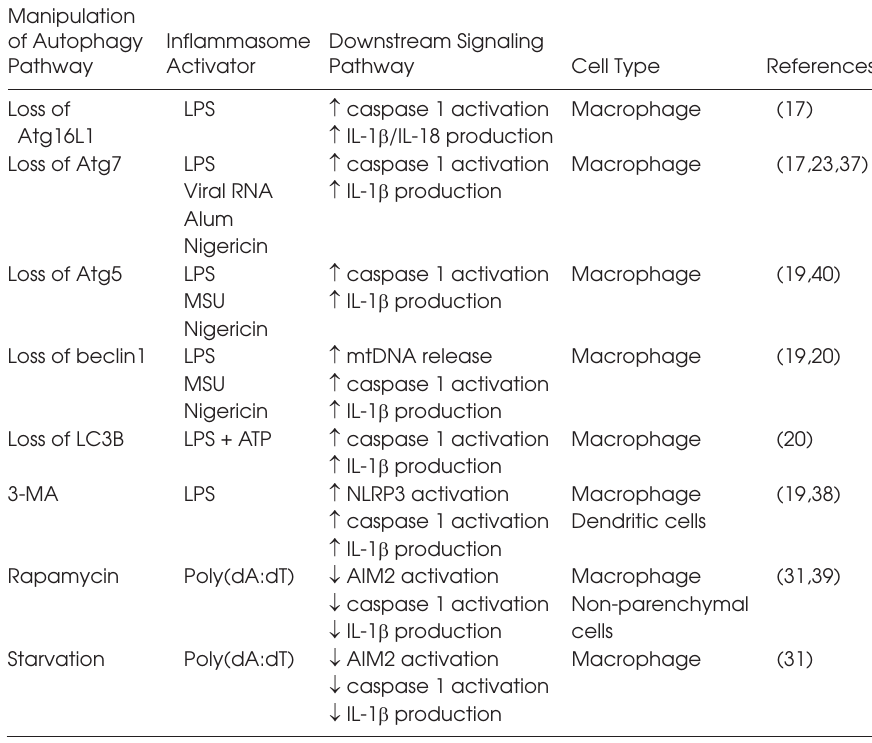
Table 1. Autophagy regulation of inflammasome